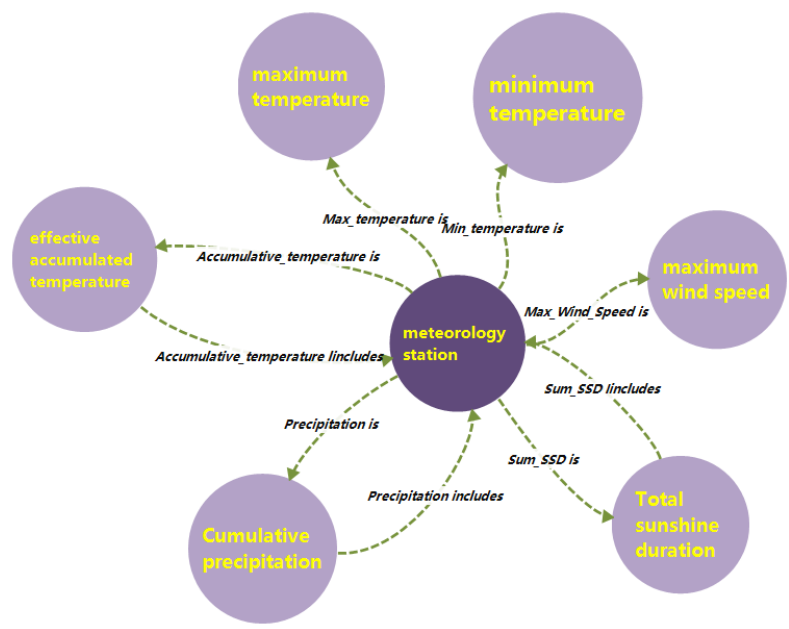
Figure 3. The schema of meteorology knowledge graph.